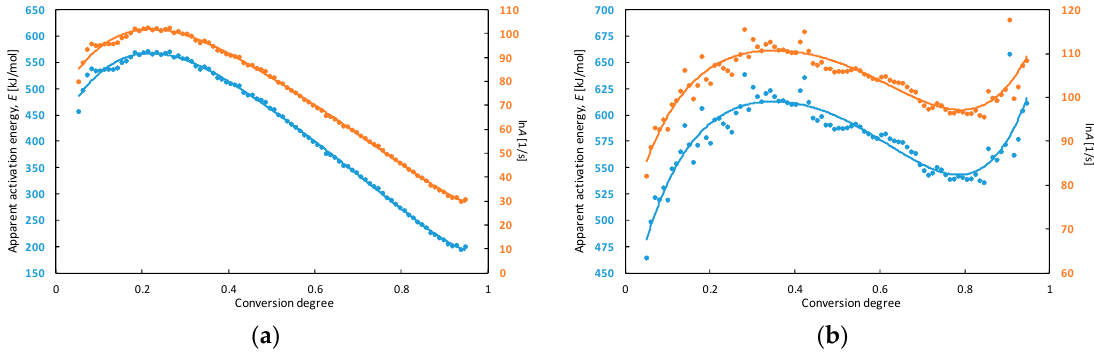
Figure 5. The dependence of apparent activation energy ( E ) and the natural logarithm of the pre-exponential factor (ln A ) on the conversion degree for TCAD achieved in DTA ( a ) and TG ( b ) measurements.